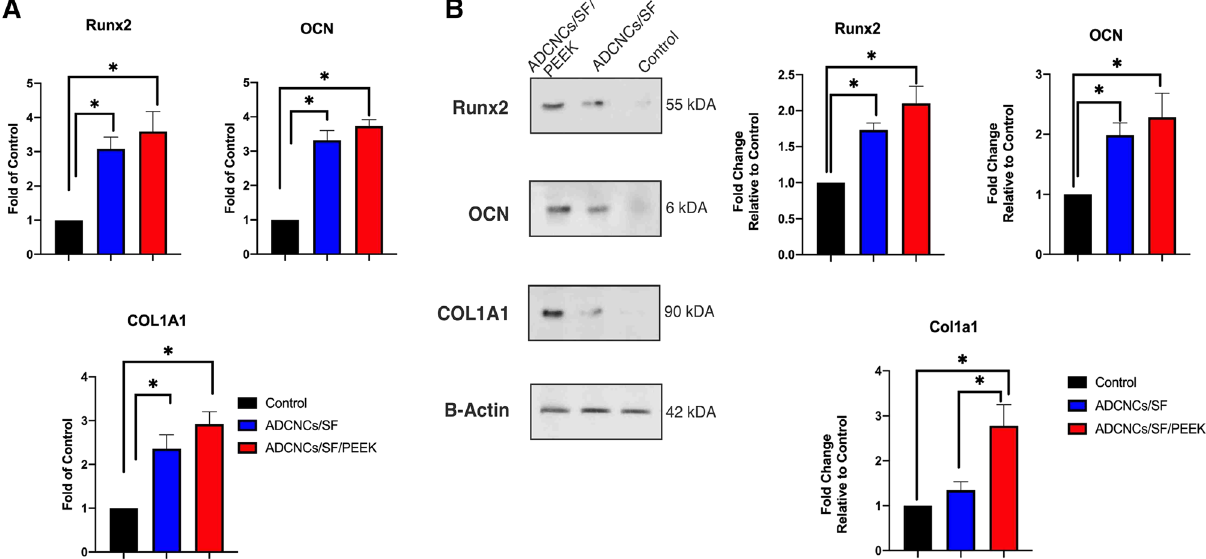
Figure 8. ( A) Expression levels of Runx2, OCN, and COL1A1 genes in hDPSCs seeded on synthesized hydrogels after 14 days increased drastically. ( B) Western blotting evaluated the secretion of the same factors in protein levels after 7 days. Seeding of hDPSCs on the synthesized hydrogels also increased the expression of evaluated osteogenic markers in protein levels. Control: DPSCs without hydrogels, ADCNCs/SF: DPSCs seeded on ADCNCs/SF hydrogel, ADCNCs/SF/PEEK: DPSCs seeded on hydrogel containing PEEK (* P < 0.05).